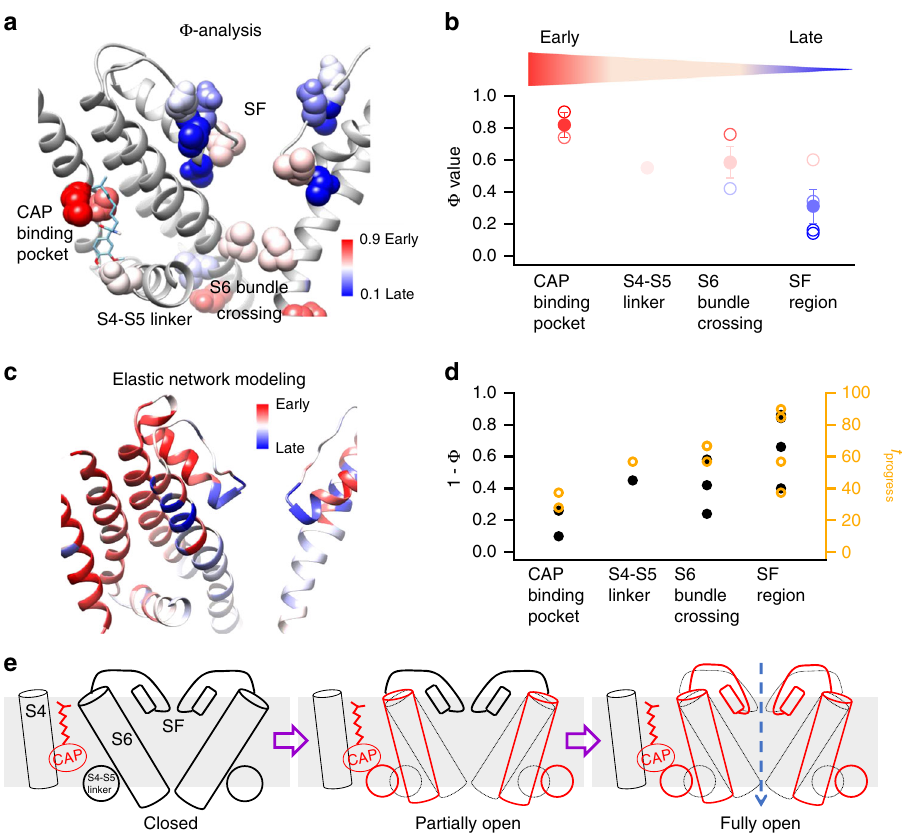
Fig. 5 The conformational wave in capsaicin activation of TRPV1. a Measured Φ values were mapped on TRPV1 structure. The sites moved early (large Φ values) or late (small Φ values) were colored in red or blue, respectively. b The Φ values were clustered and averaged by their locations. Capsaicin-binding pocket (M548 and T551): 0.82 ± 0.08; S4 – S5 linker (E571): 0.55; S6 bundle crossing (I680, L682, and E685): 0.59 ± 0.10; Selectivity fi lter (T642, I643, D647, L648, and E649): 0.31 ± 0.11. c f progress values calculated by iENM were mapped on TRPV1. Residues moved early (small f progress value) or late (large f Φ values (black) and f progress value) were colored in red or blue, respectively. d The progress values (orange) matched well with each other in multiple domains. e A schematic diagram showing the temporal sequence of events upon capsaicin binding that lead to the full activation of TRPV1. All statistical data are given as mean ±